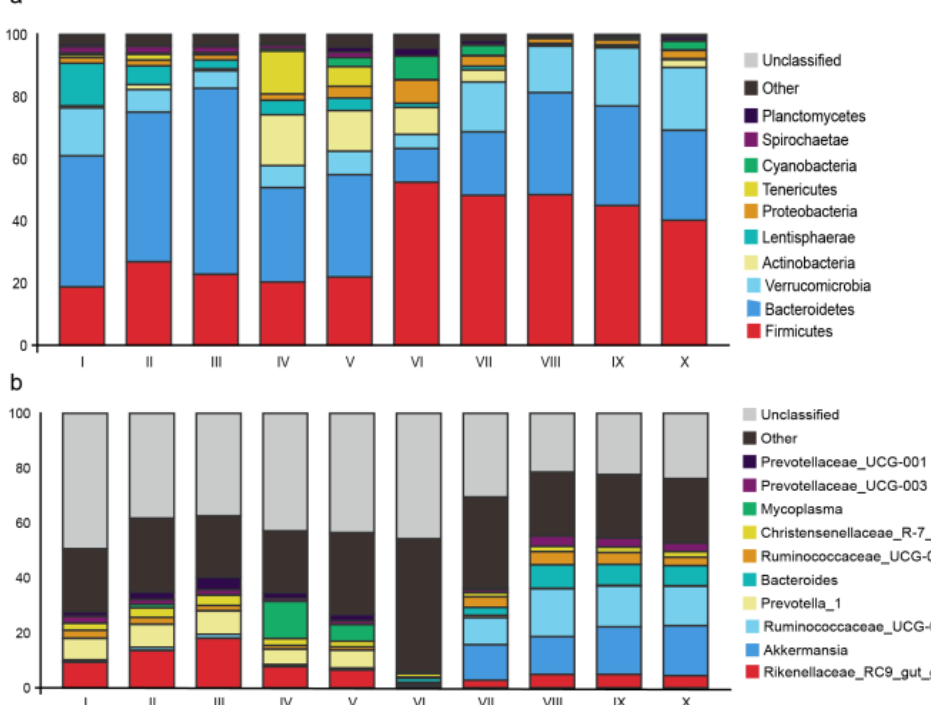
Figure 1. Stack graph shows the bacterial composition based on abundance at the phylum level ( a ) and genus level ( b ) in 10 sections: rumen ( Ⅰ ), reticulum ( Ⅱ ), omasum ( Ⅲ ), abomasum ( Ⅳ ), duode- num ( Ⅴ ), jejunum ( Ⅵ ), ileum ( Ⅶ ),caecum ( Ⅷ ), colon ( Ⅸ ) and rectum ( Ⅹ